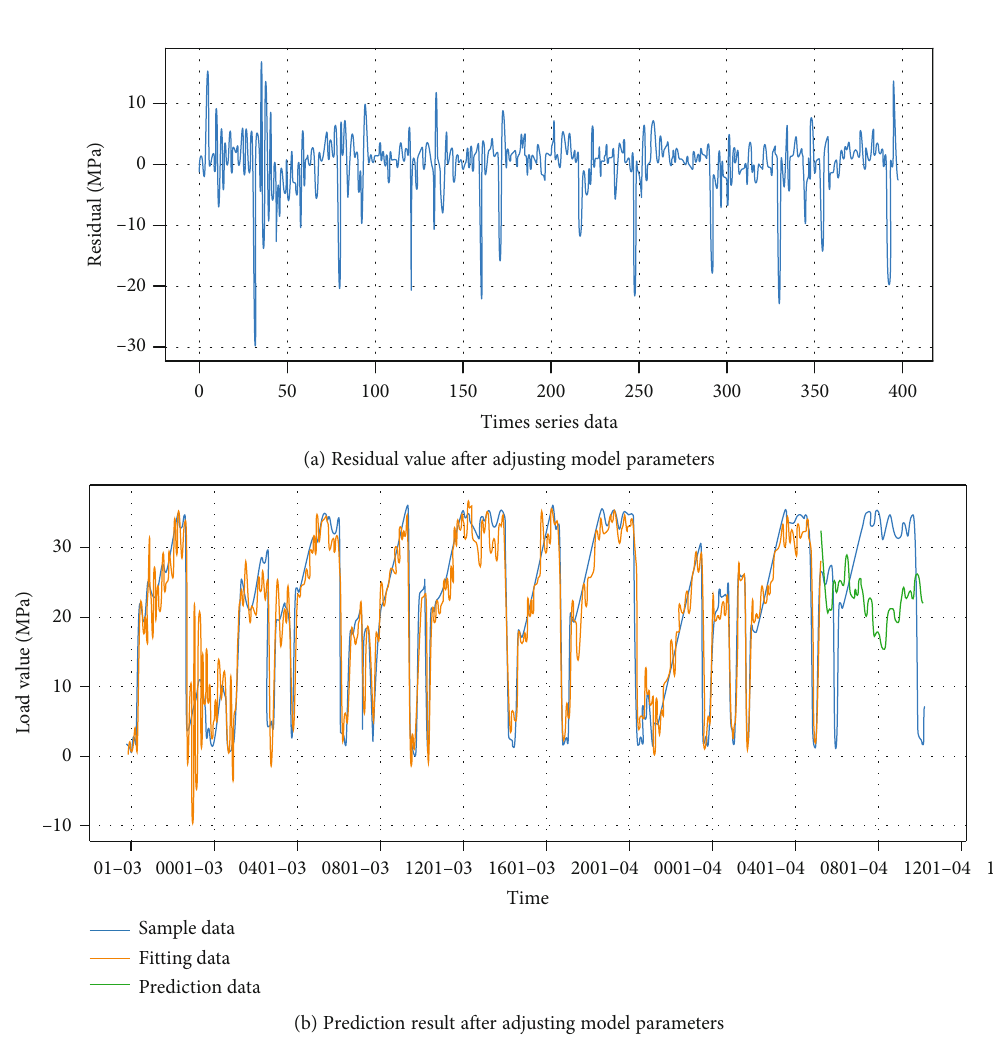
Figure 9: The residual value and prediction result of the model with the adjusted